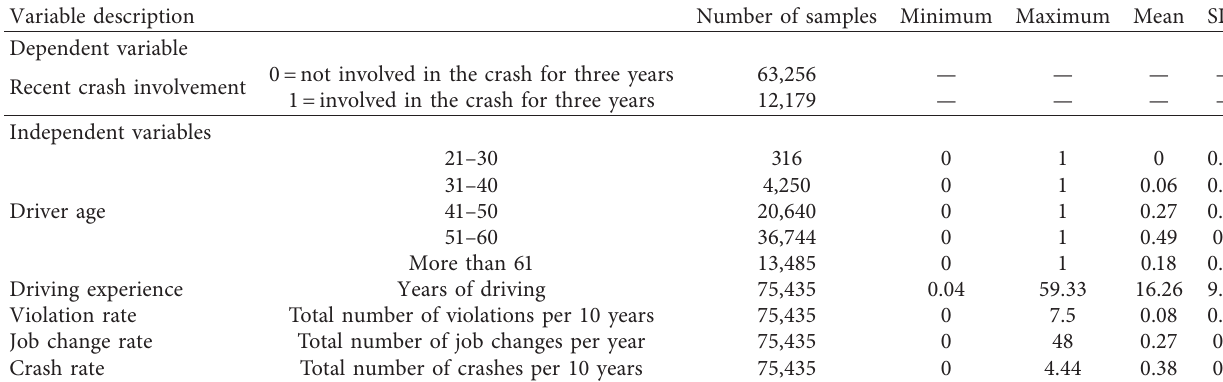
Table 1: Descriptive statistics of variables for local bus.